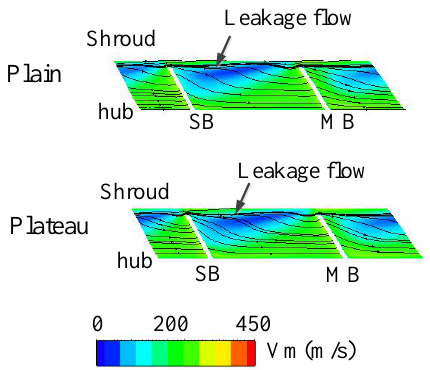
Figure 18. Relative meridional velocity and streamline distribution at channel section of the impeller trailing edge.